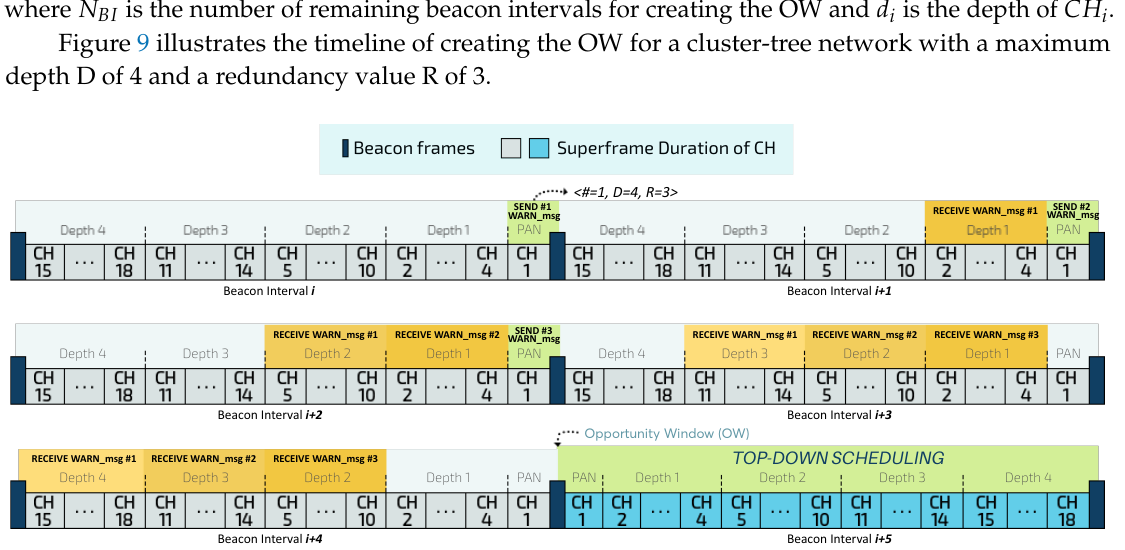
Figure 9. Timeline of the process of creating an Opportunity